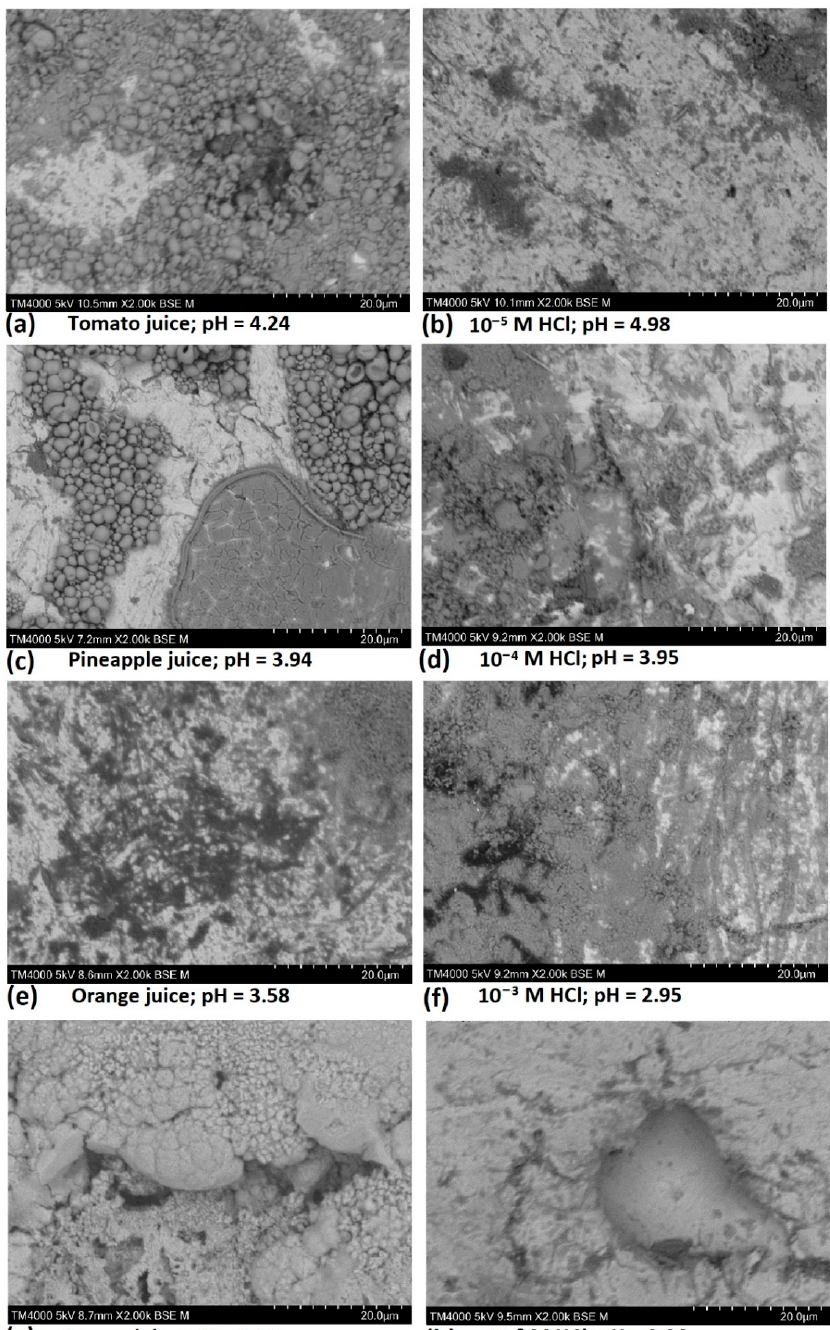
Figure 5. SEM images of carbon steel sheet (CR1 ≈ EN 1.0338) surfaces after immersion in ( a ) tomato juice, ( b ) 10 -5 M HCl, ( c ) pineapple juice, ( d ) 10 -4 M HCl, ( e ) orange juice, ( f ) 10 -3 M HCl, ( g ) lemon juice, and ( h ) 10 -2 M HCl, respectively.